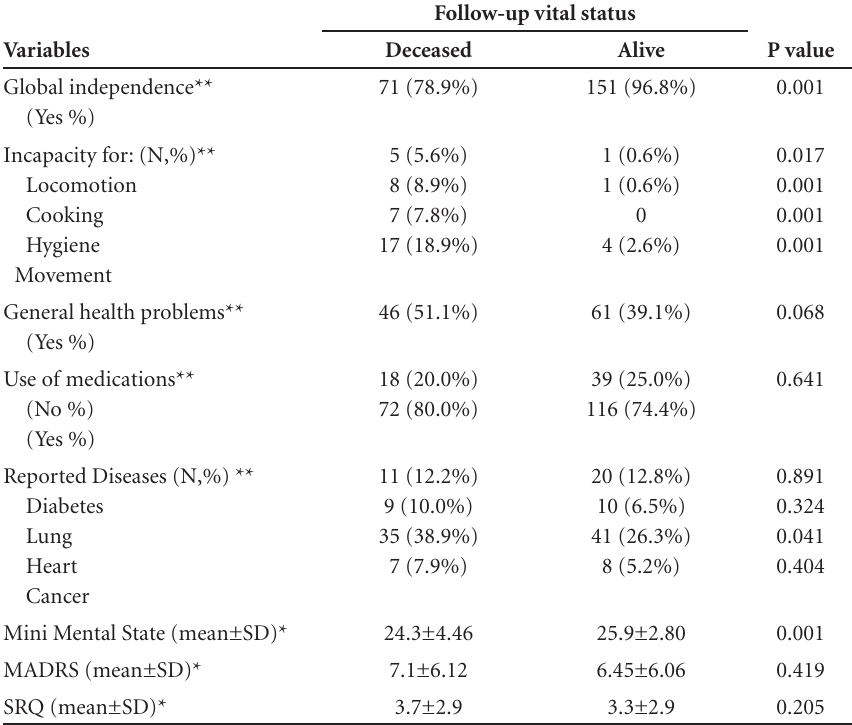
Table 3. Medical, cognitive and psychiatric baseline data of sample according to outcome (vital status) during follow-up.